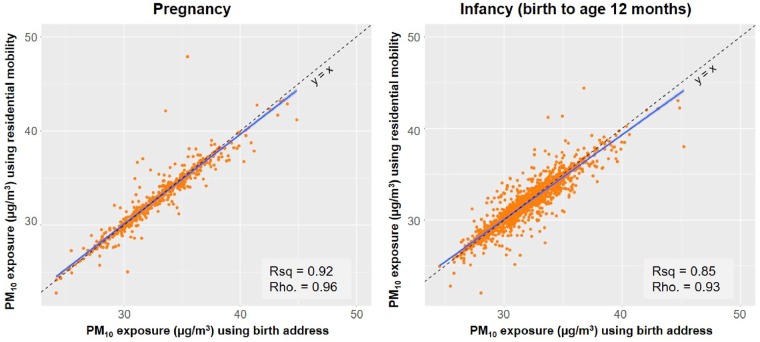
Estimated PM10 exposure at residential address comparing birth address only with residential mobility during pregnancy and infancy. Solid line is the linear regression fit line and the dashed line is identity.